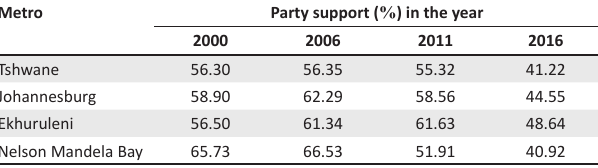
TABLE 2: Party support in local government elections in key ANC-dominant metros,